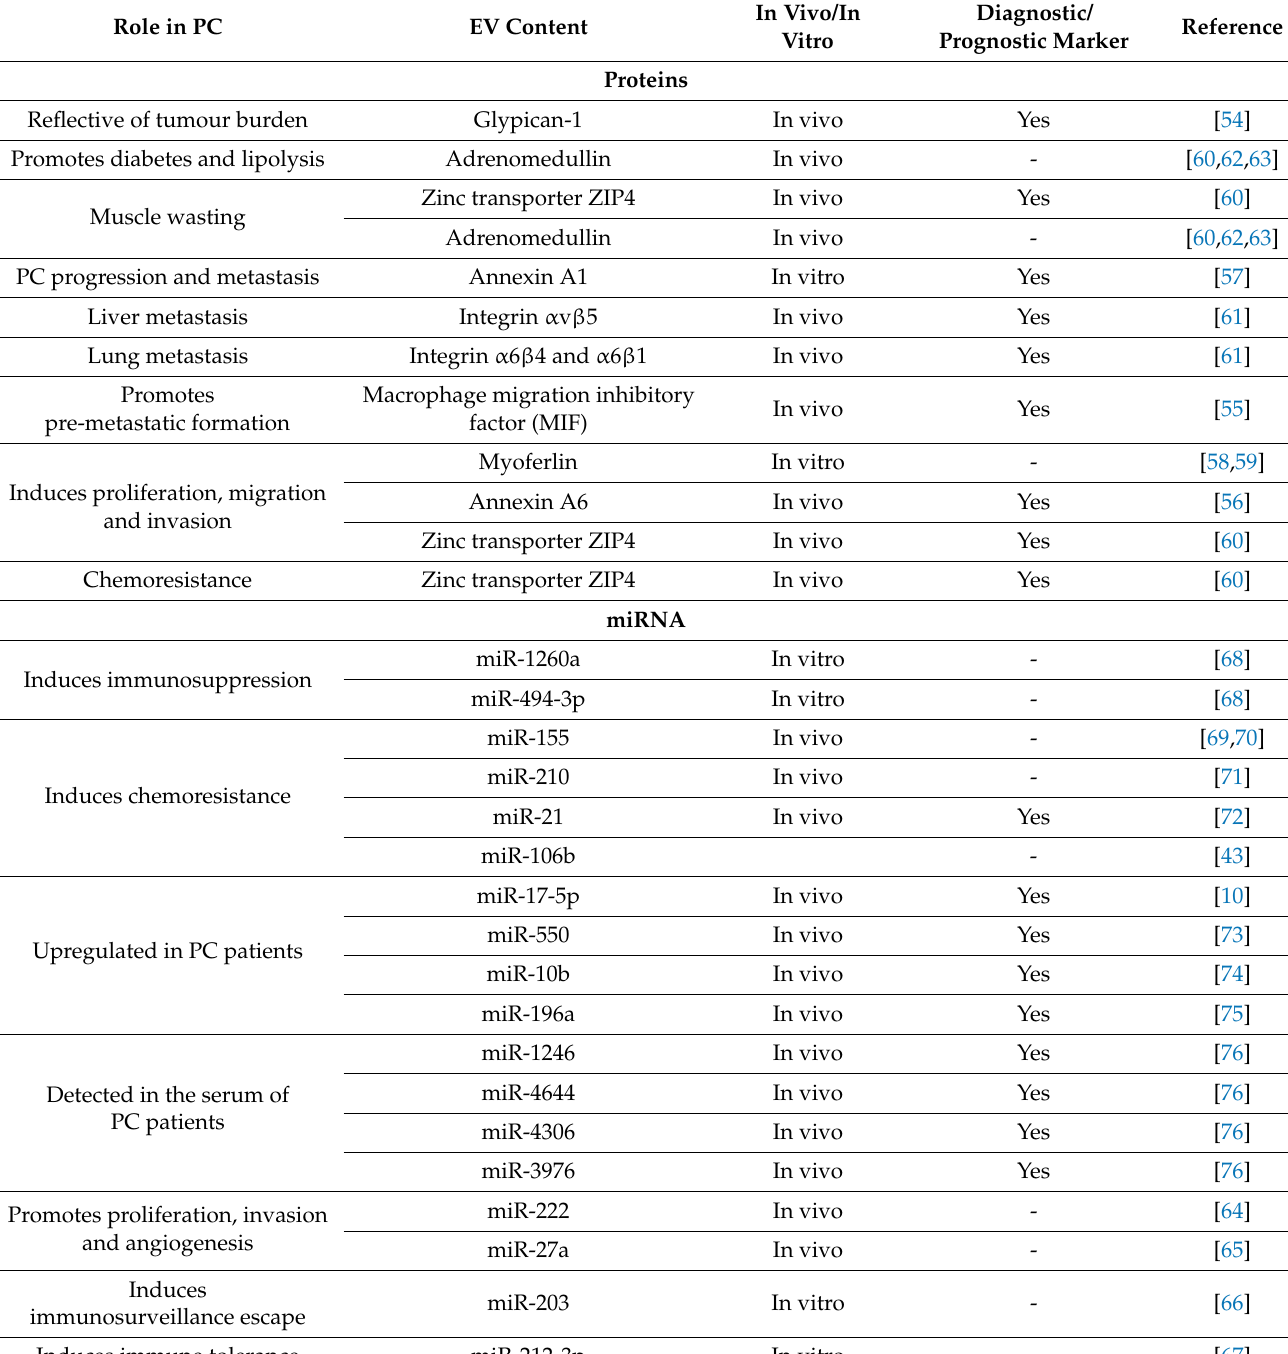
Table 1. Pancreatic cancer-derived EV content and their role in pancreatic